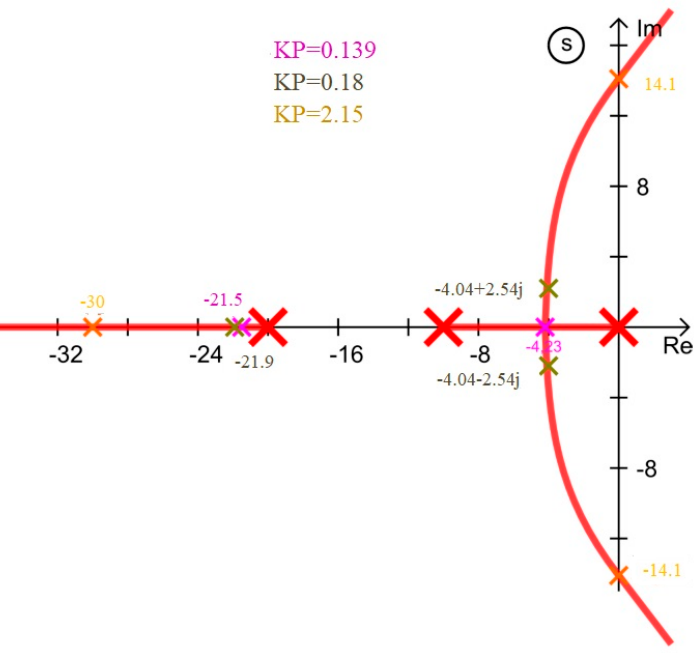
Figure 6. Root locus of the speed controller with smoothing in the feedback.